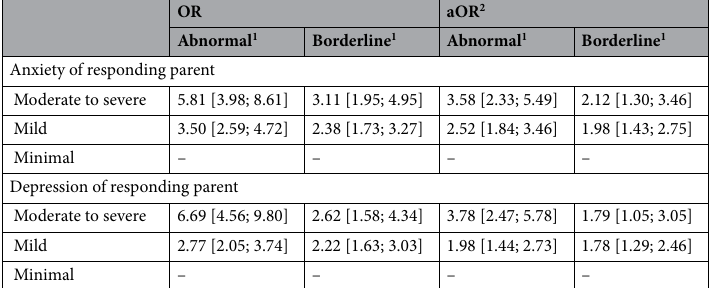
Table 4. Association between parents’ mental health issues and children’s emotional symptoms score: multinomial logistic regressions (n = 3496). 1 Normal score is reference group. 2 Results adjusted on child’s hyperactivity/inattention score, child’s sleeping difficulties, child’s sex, sex of responding parent, if the child lived with both parents, parents’ occupational category, household income per month before lockdown and perceived financial situation since lockdown.